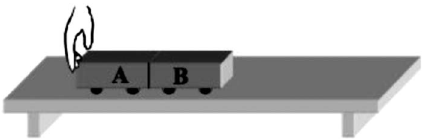
FIG. 1. Carts A and B are on a table as shown. A constant force is exerted on cart A by the hand so that the carts speed up at a constant rate. Compare the magnitudes and directions of the force exerted on cart B by cart A with the force exerted on cart A by cart B .